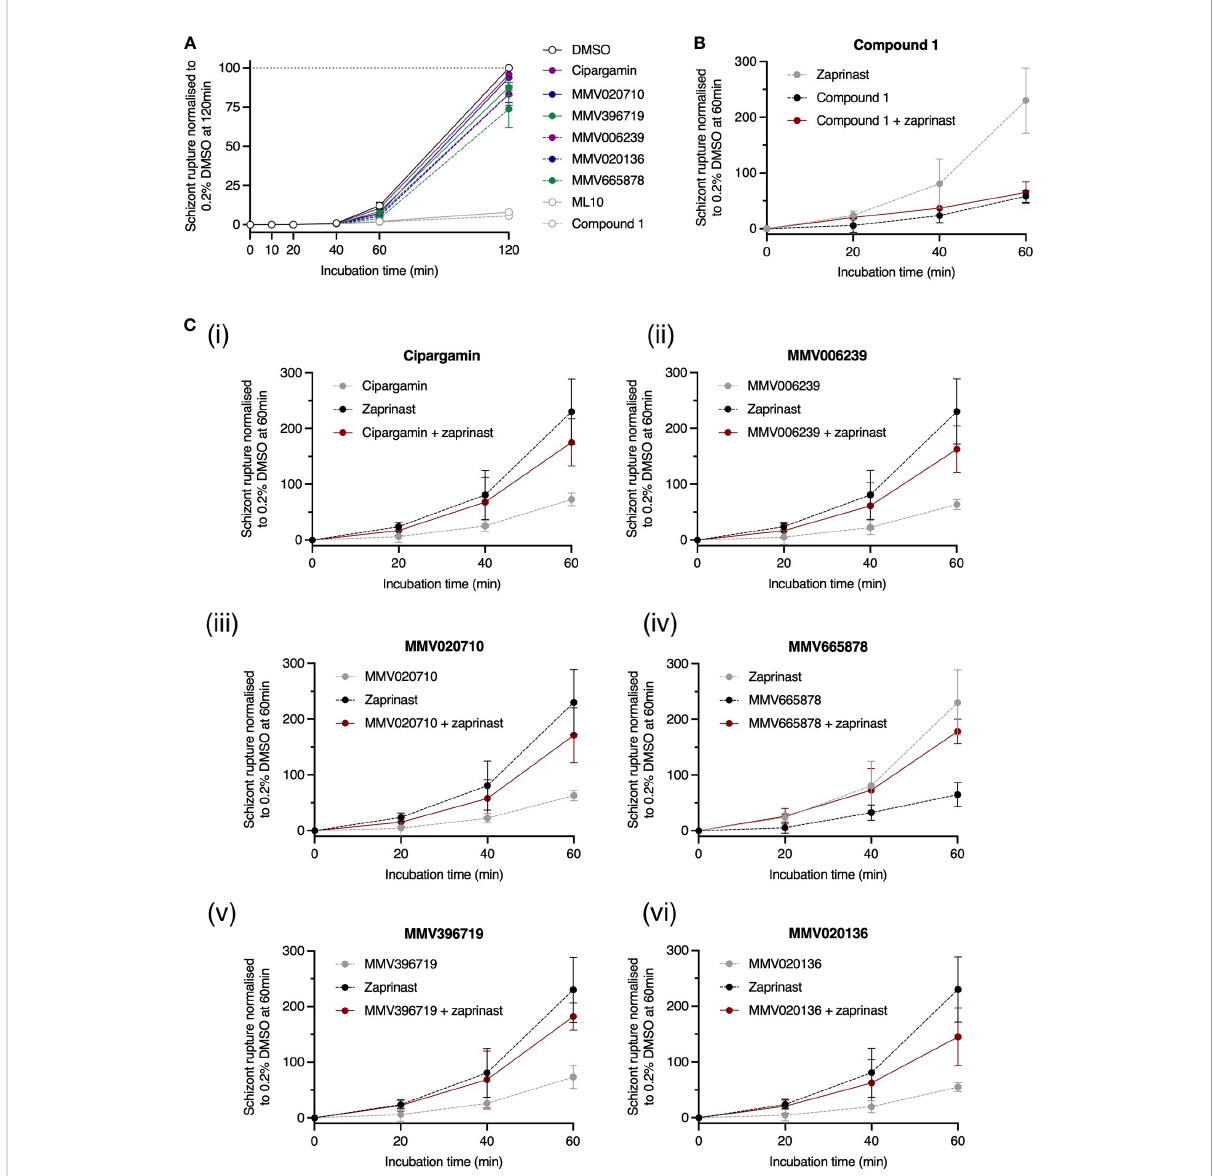
FIGURE 7 Pf ATP4 inhibitors likely act upstream of the cGMP/ Pf PKG checkpoint to inhibit egress. (A) 3D7_Hyp1-Nluc trophozoites were grown overnight with the Pf PKG inhibitor ML10 (25 nM). ML10 was subsequently removed from the schizont cultures and Pf ATP4 inhibitors were